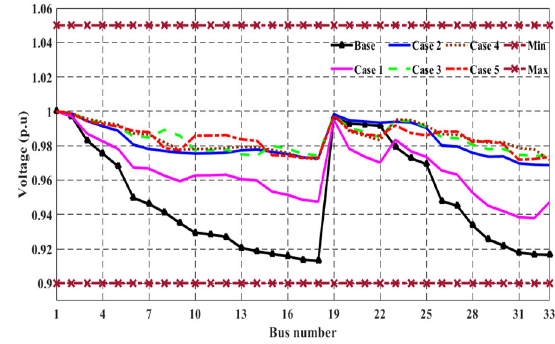
Fig. 6: Voltage Profile of All Cases for 33-Bus System